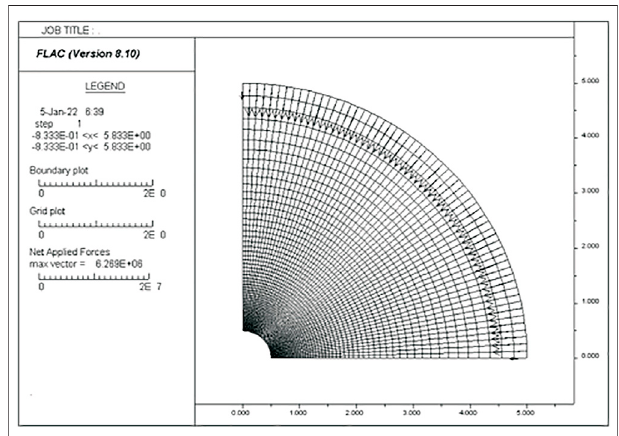
FIGURE 5 | Grid used in the numerical simulations with